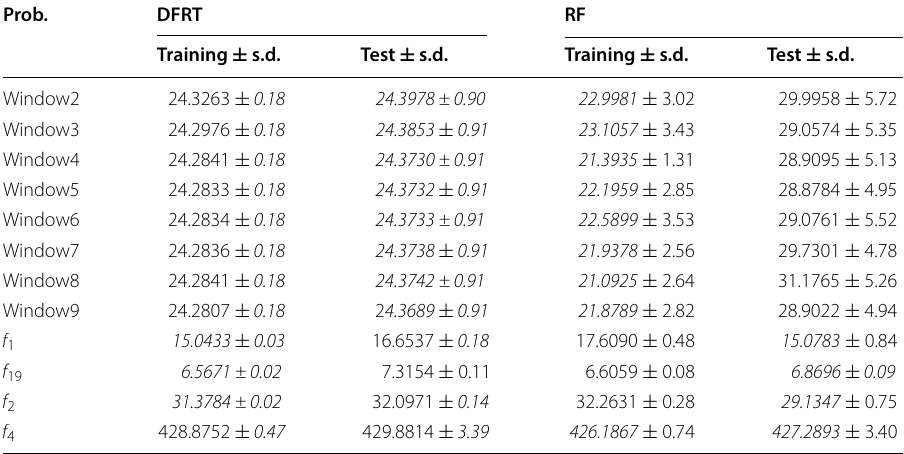
The best results for each dataset have been emphasized in italic font The results have to be multiplied by 10 21 , 10 22 , 10 4 and 10 31 for f 1 , f 19 , f 2 and f 4 respectively